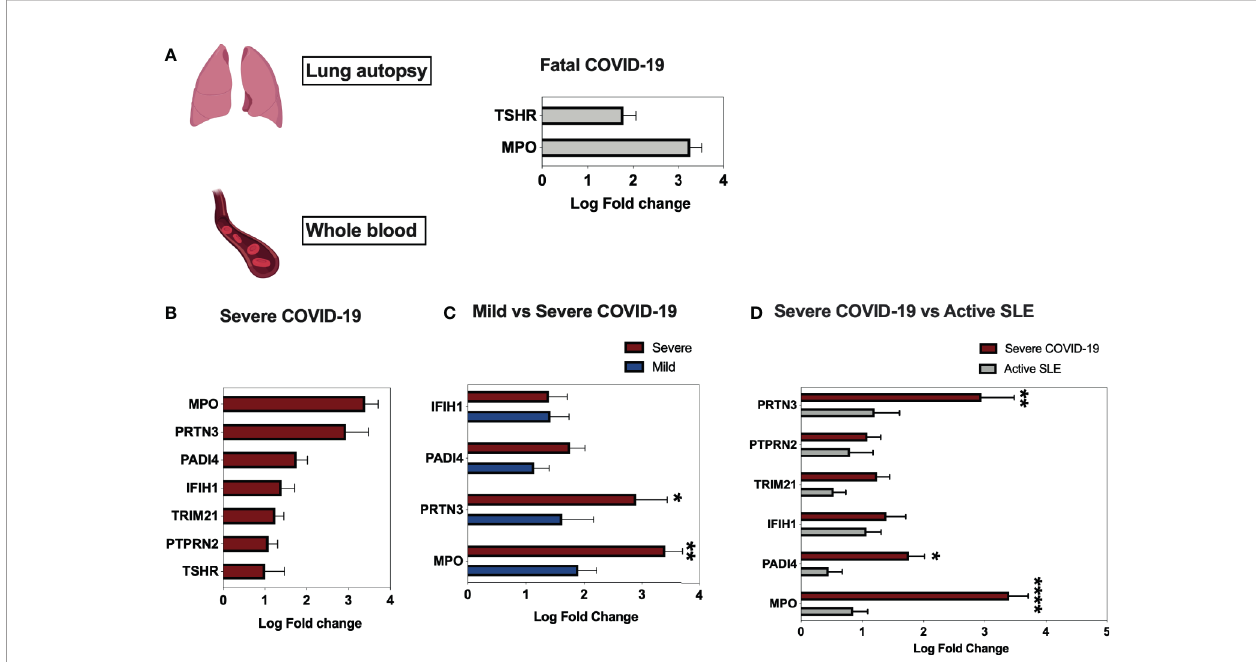
FIGURE 1 | Gene expression of autoantigens in lung autopsies and whole blood of COVID-19 patients. (A) Enhanced expression of MPO and TSHR autoantigens in lung autopsies (n = 9 COVID-19 vs n = 10 controls, Dataset: PRJNA646224). (B) For whole blood COVID-19 dataset (EGAS00001004503), seven autoantigens were upregulated in severe COVID-19 vs controls comparison (C) , four autoantigens were upregulated in mild COVID-19 vs controls. The upregulation of MPO and PRTN3 was higher in severe versus mild COVID-19. The sample size presented in B – C EGAS00001004503 dataset was as following; n = 10 controls, n = 19 mild COVID- 19, and n = 20 severe COVID-19. Results are presented as log fold change of gene expression with adjusted p-values of less than 0.05. The log fold changes were compared between severe and mild COVID-19 groups. (D) Upregulation of autoantigens in whole blood of both severe COVID-19 and active systemic lupus erythematosus patients. The following datasets were used; EGAS00001004503 (n = 20 severe COVID-19 vs n = 10 controls), and Panousis et al. (35) (n = 79 active SLE vs n = 58 controls). Unpaired student t-test was used to compare between each two independent groups. ∗ p < 0.05, ∗∗ p < 0.01, ∗∗∗∗ p <